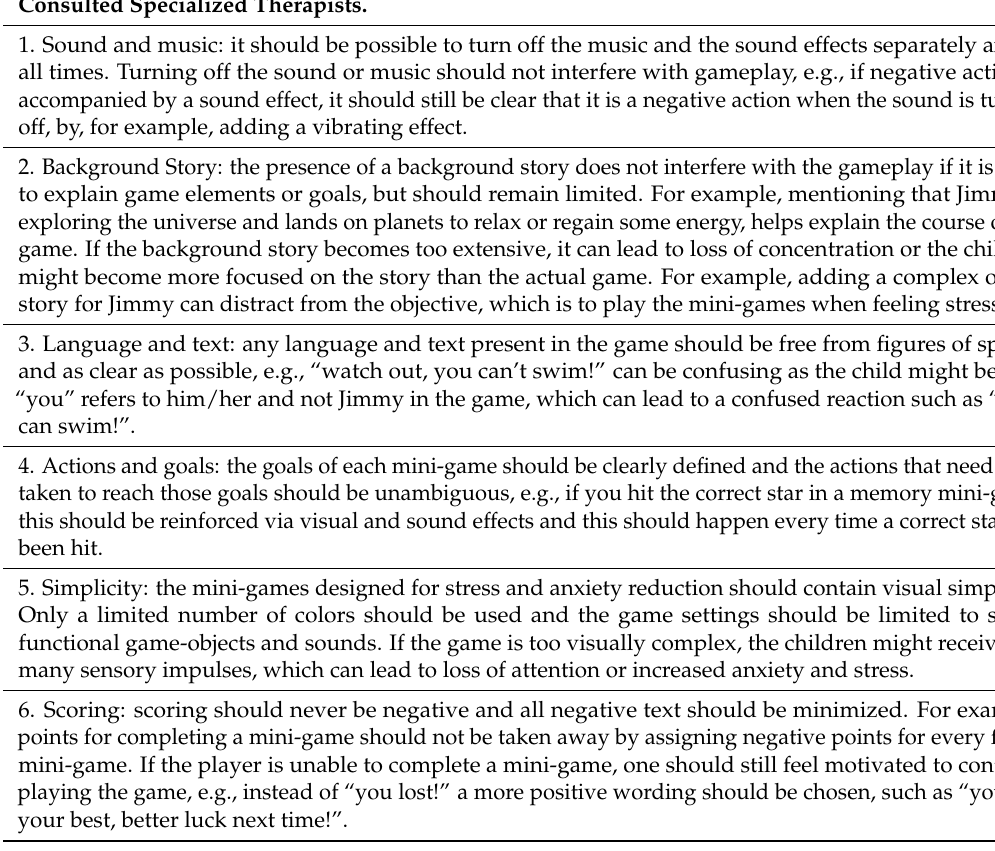
Table 5. Guidelines for the design of serious games for children with ASD, based on the remarks and feedback during multiple feedback sessions with specialized